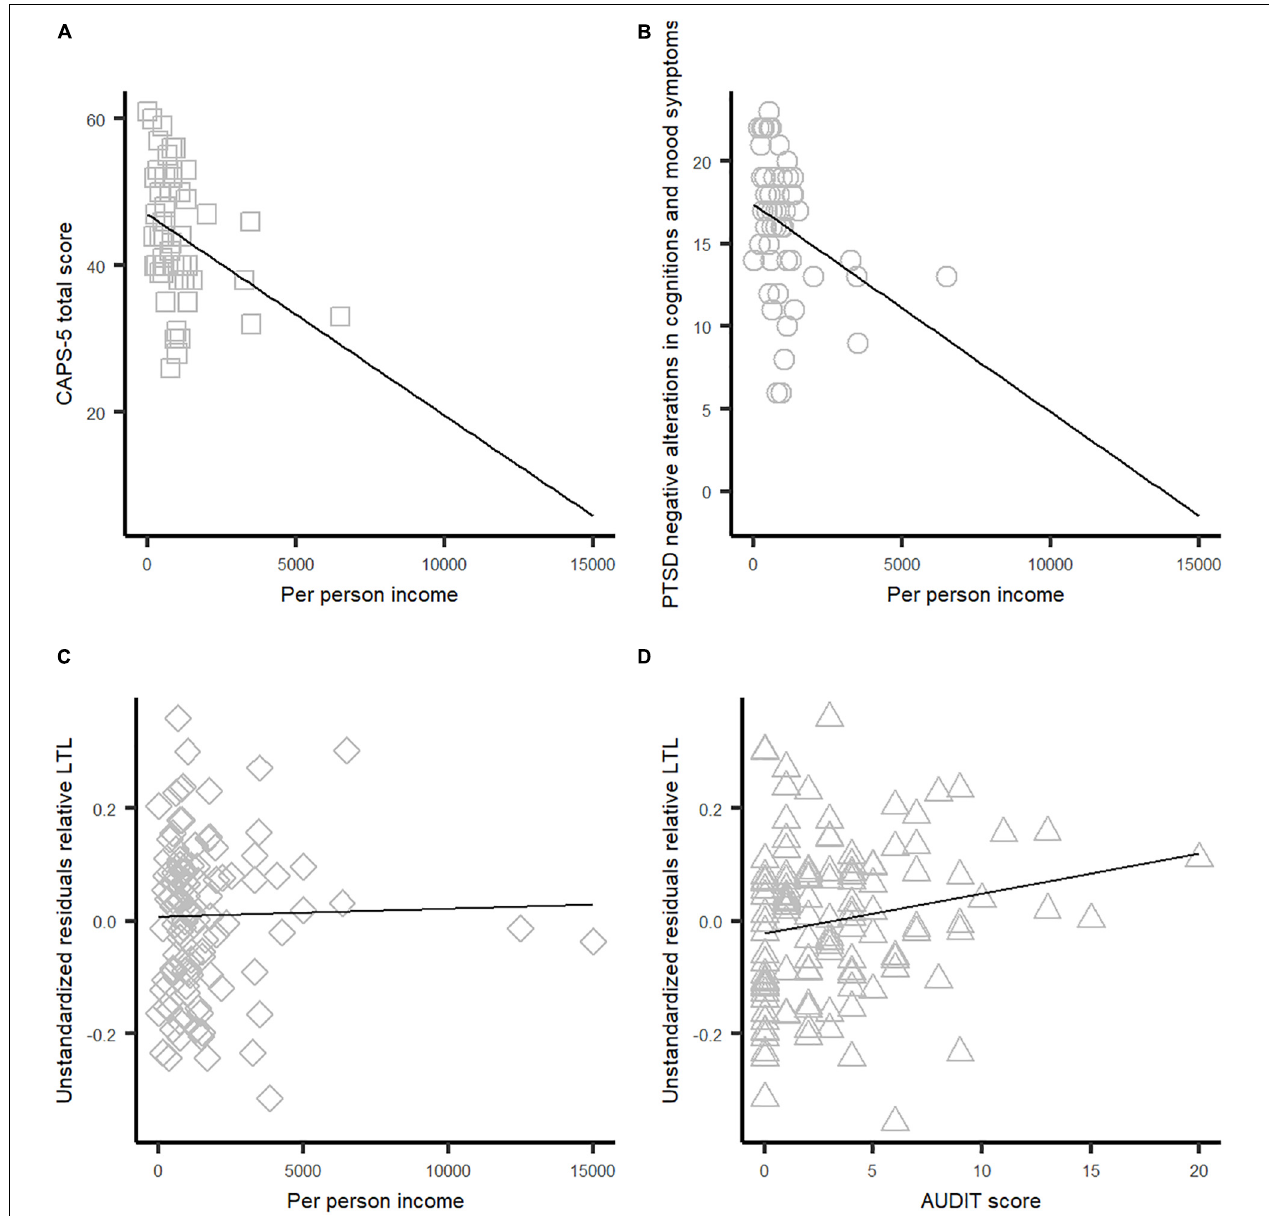
FIGURE 1 | Scatter plots of correlations tests among per-person income, PTSD symptoms, and relative LTL adjusted by age. (A) Correlation between CAPS-5 total score and per-person income. (B) Correlation between negative alterations in cognitions and mood score and per-person income. (C) Correlation between relative LTL and per-person income. (D) Correlation between relative LTL and AUDIT